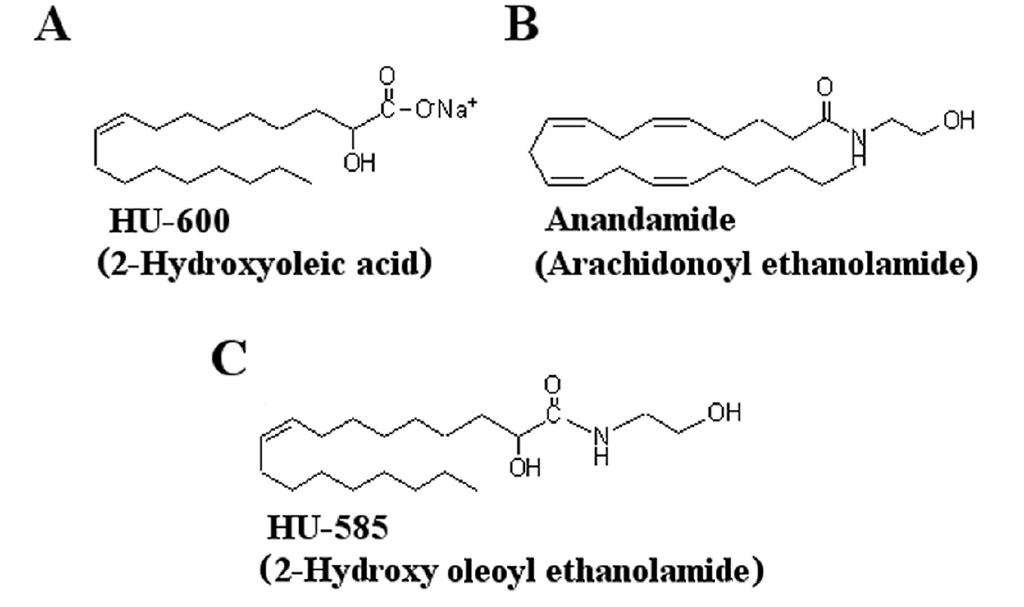
Figure 1. Structures of the synthetic compounds tested for anticancer activity . Structures of ( A ) HU − 600 (Minerval, 2 − hydroxyoleic acid), ( B ) anandamide (AEA) and ( C ) HU − 585 that was ob- tained by structural modification and the addition of AEA side chain to HU − 600.